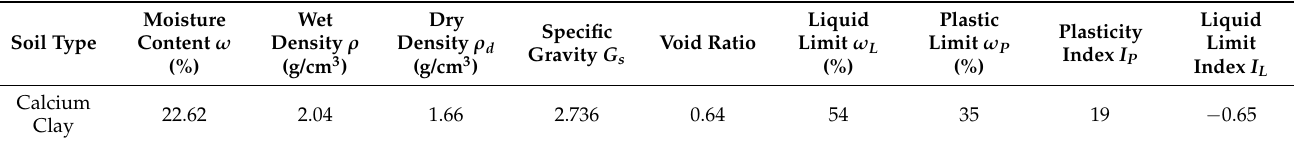
Table 1. Geotechnical test results of the studied frozen soil [22].